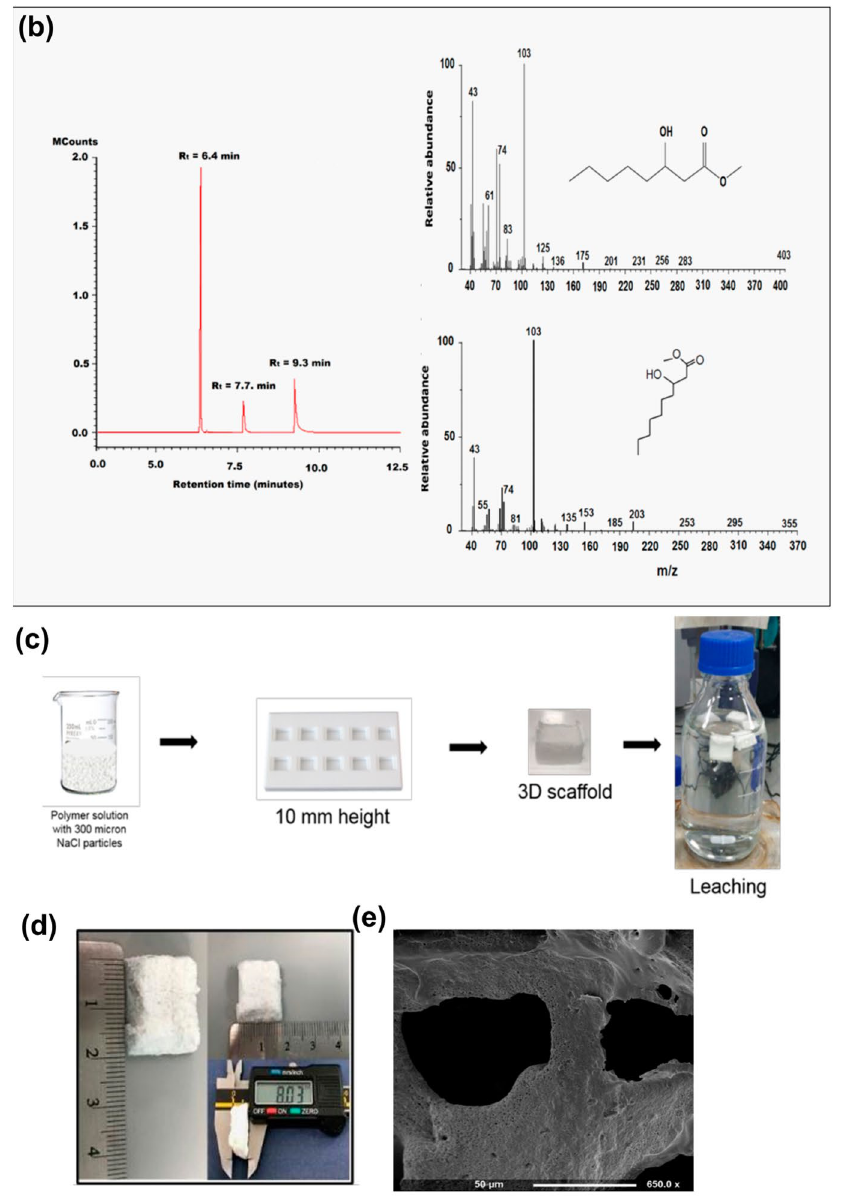
Figure 1. ( a ) GC-MS spectra of P(3HB) and ( b ) P(3HO- co -3HD). ( c ) Schematic representation of the preparation of porous 3D PHA scaffolds. ( d ) An optical image of air-dried porous 3D PHA scaffolds 20 mm × 15 mm × 8 mm. ( e ) SEM images of the P(3HB)/P(3HO- co -3HD) 50:50 3D PHA